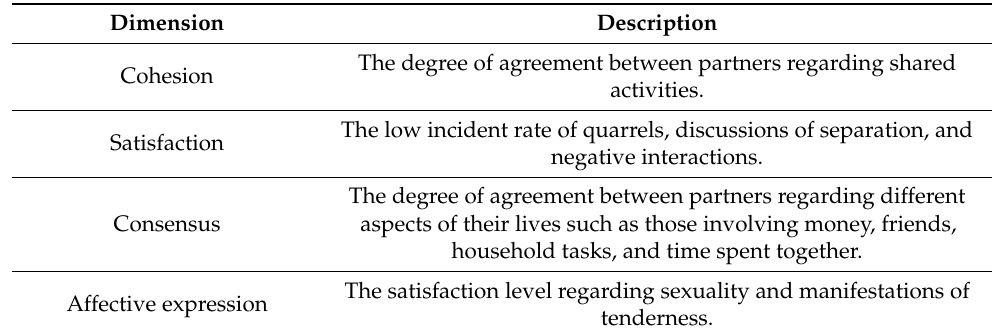
Table 2. Dimensions of couple dyadic